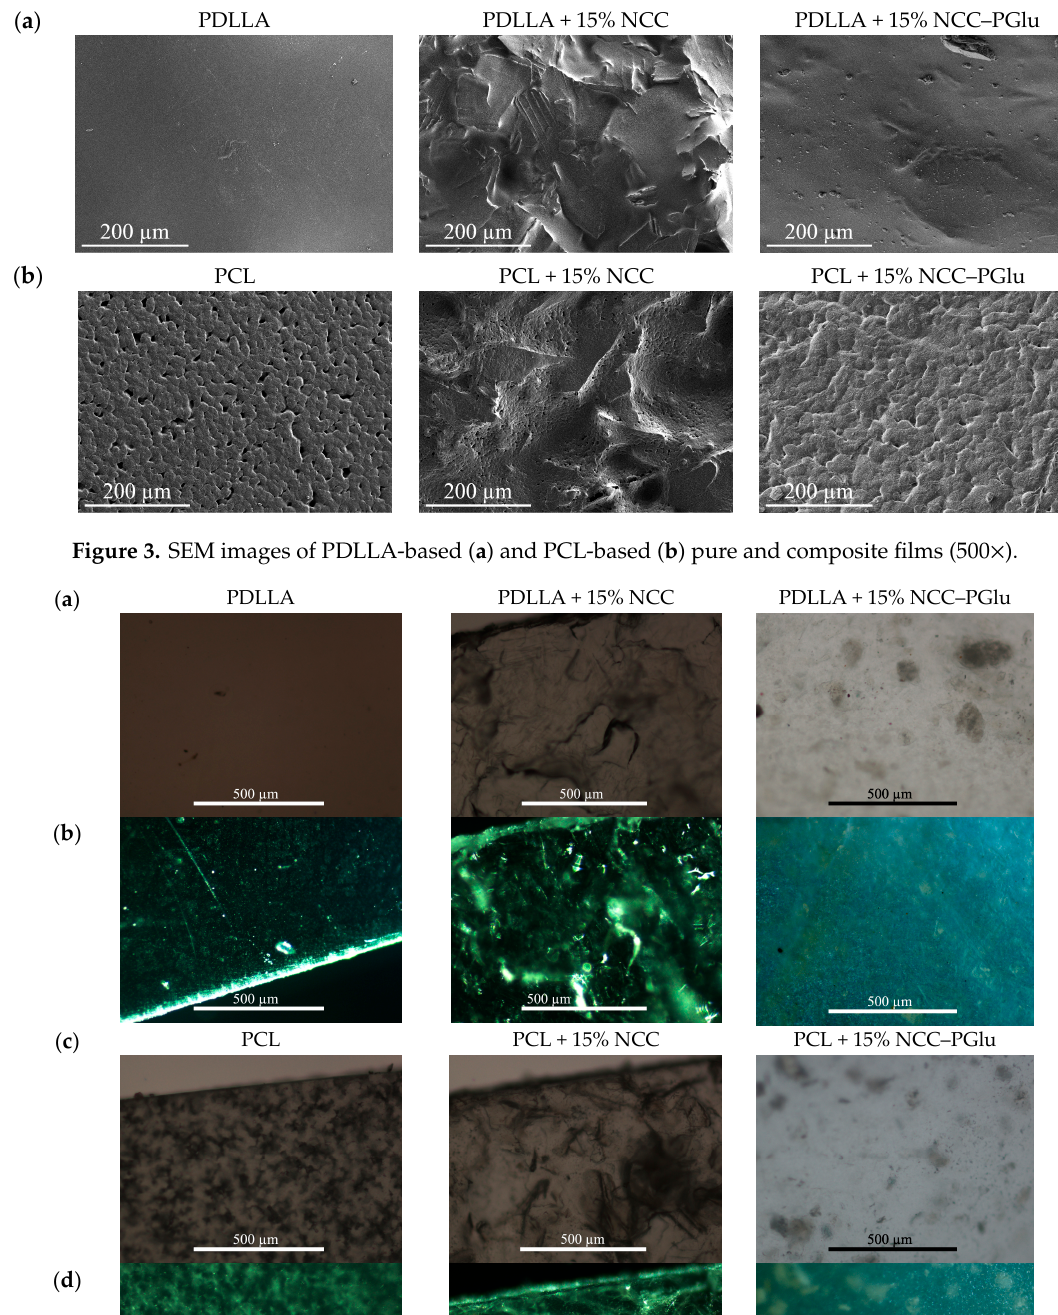
Figure 4. Optical transmitted light ( a , c ) and reflected ( b , d ) microscopy images registered for pure PDLLA and PCL and their composites with neat and modified NCC (10 × ).